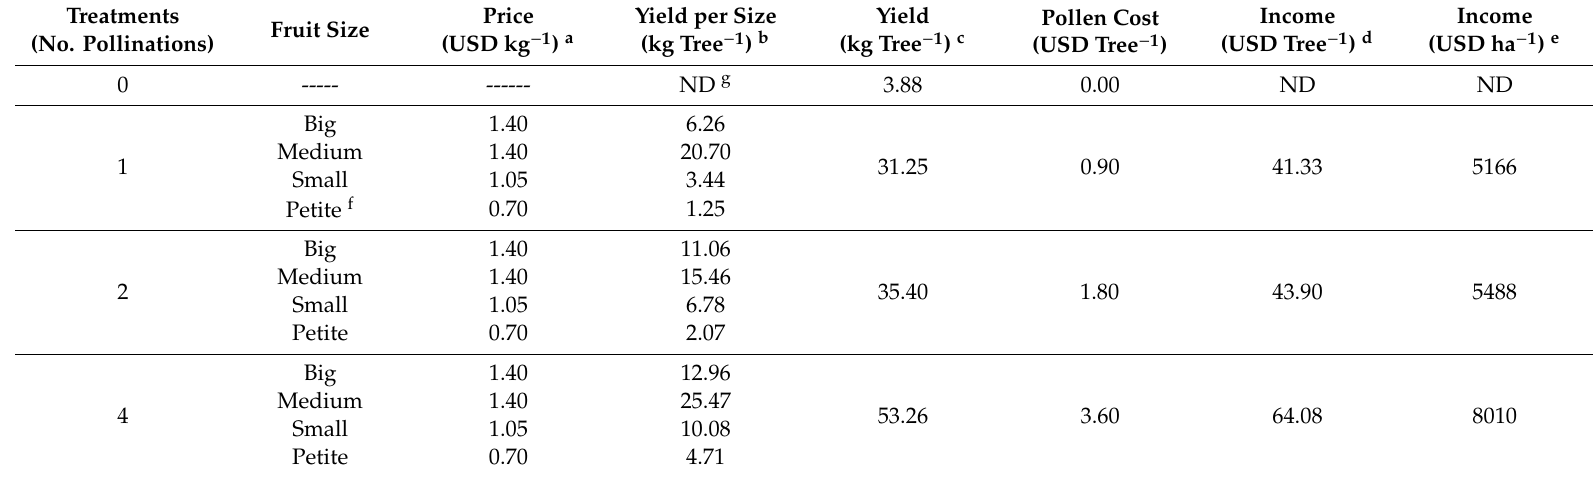
Table 2. E ff ects of di ff erent frequencies of artificial pollination on yield and income in heavy-flowering ‘Manzanillo’ trees. Year 2017.